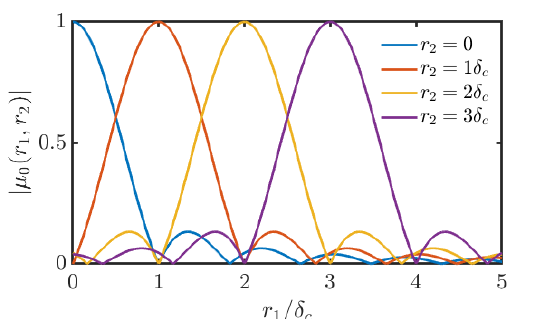
Figure 2. Absolute value of the degree of coherence as a function of the radius r 1 for different distances r 2 from the source